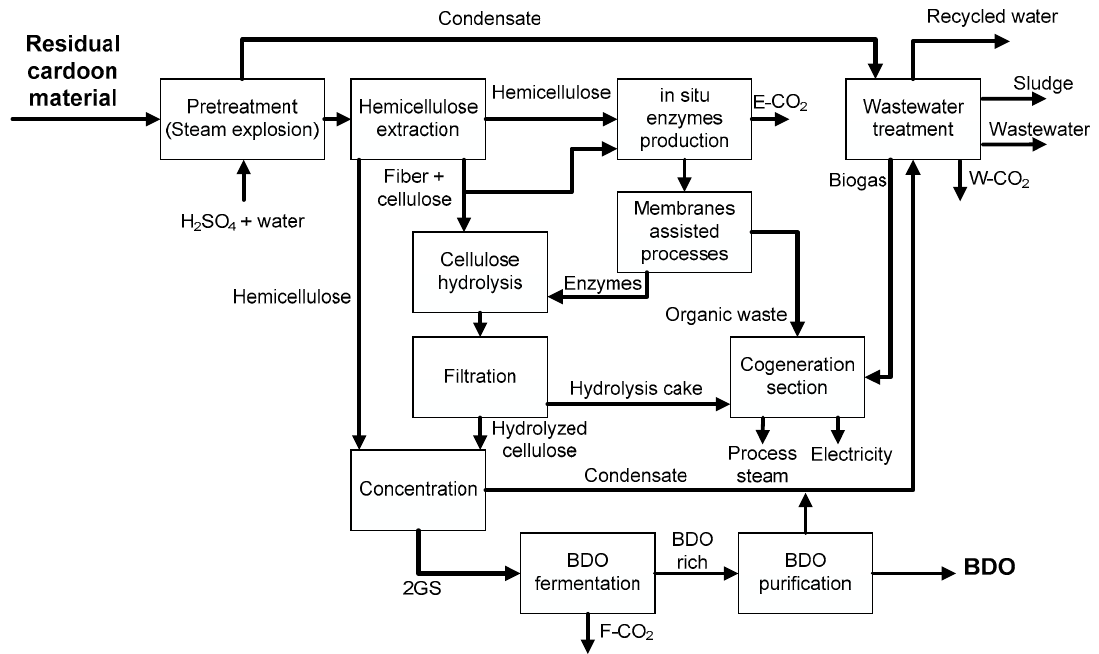
Figure 1. Process flowsheet for the bio-based 1,4-butanediol production from cardoon.